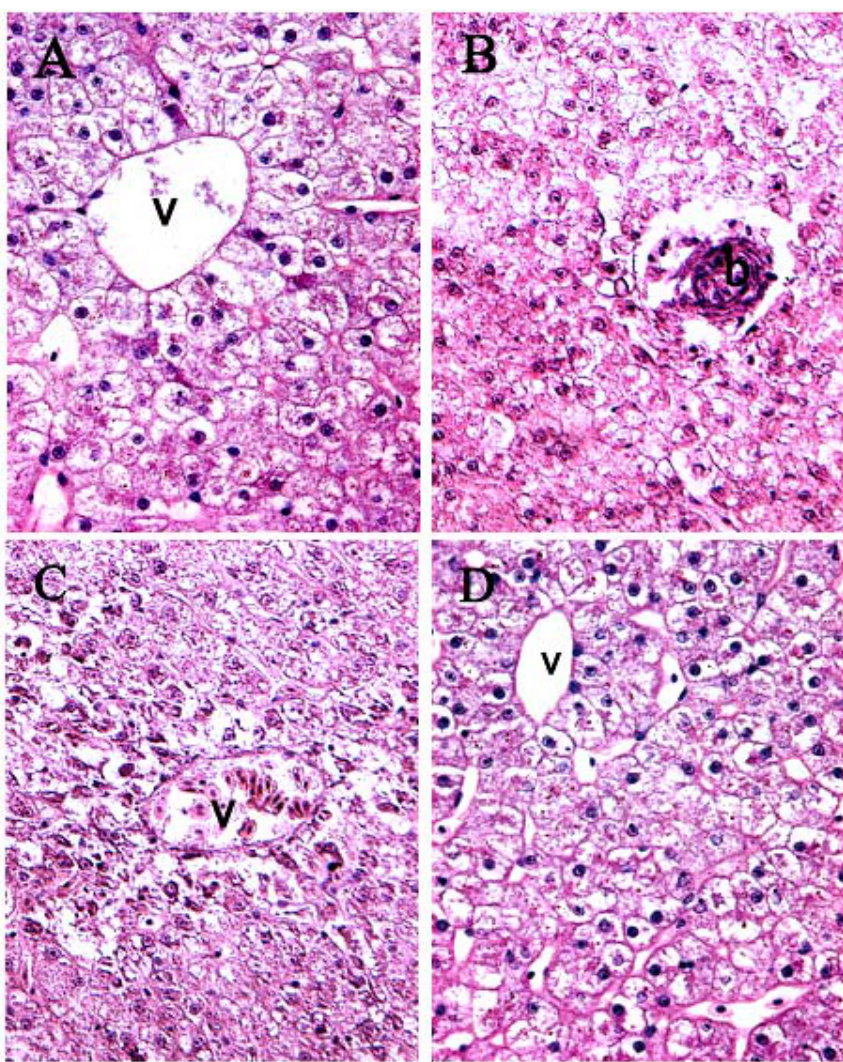
FIGURE 3. H&E-stained liver of sections of bighead carp collected from the fish pen in Meiliang Bay of Taihu Lake (400× magnification; v, central vein). (A) An example of a normal liver, which was the specimen obtained during April and May, 2004; (B and C) the examples of hepatocyte vacuolation and disorganization of cell structure in periportal and central region, which were typical of liver sections obtained during July and August, 2004; (D) an example of recovery of liver structure, which was typical of liver sections obtained from November 2004 to March